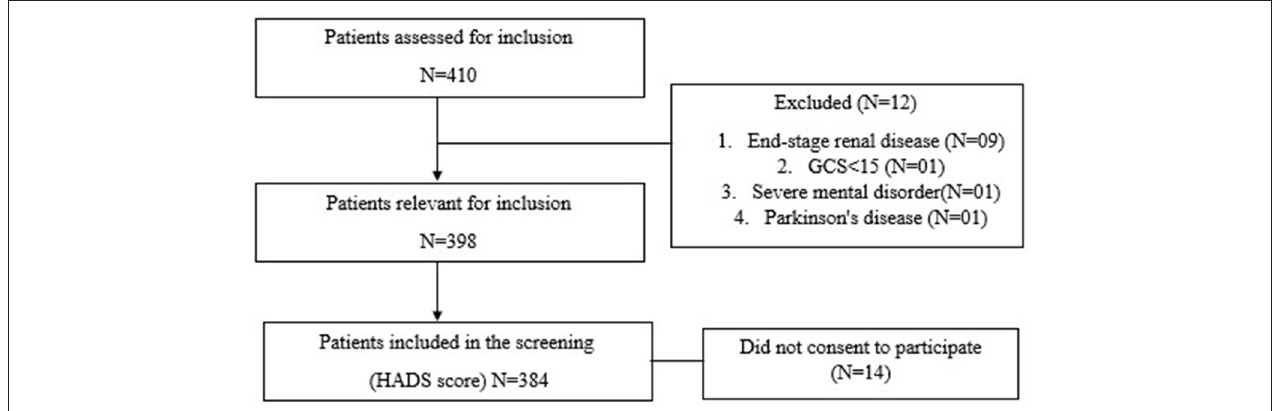
FIGURE 1 | Flowchart of patients assessed for inclusion, excluded, and included patients, HADS, Hospital Anxiety and Depression